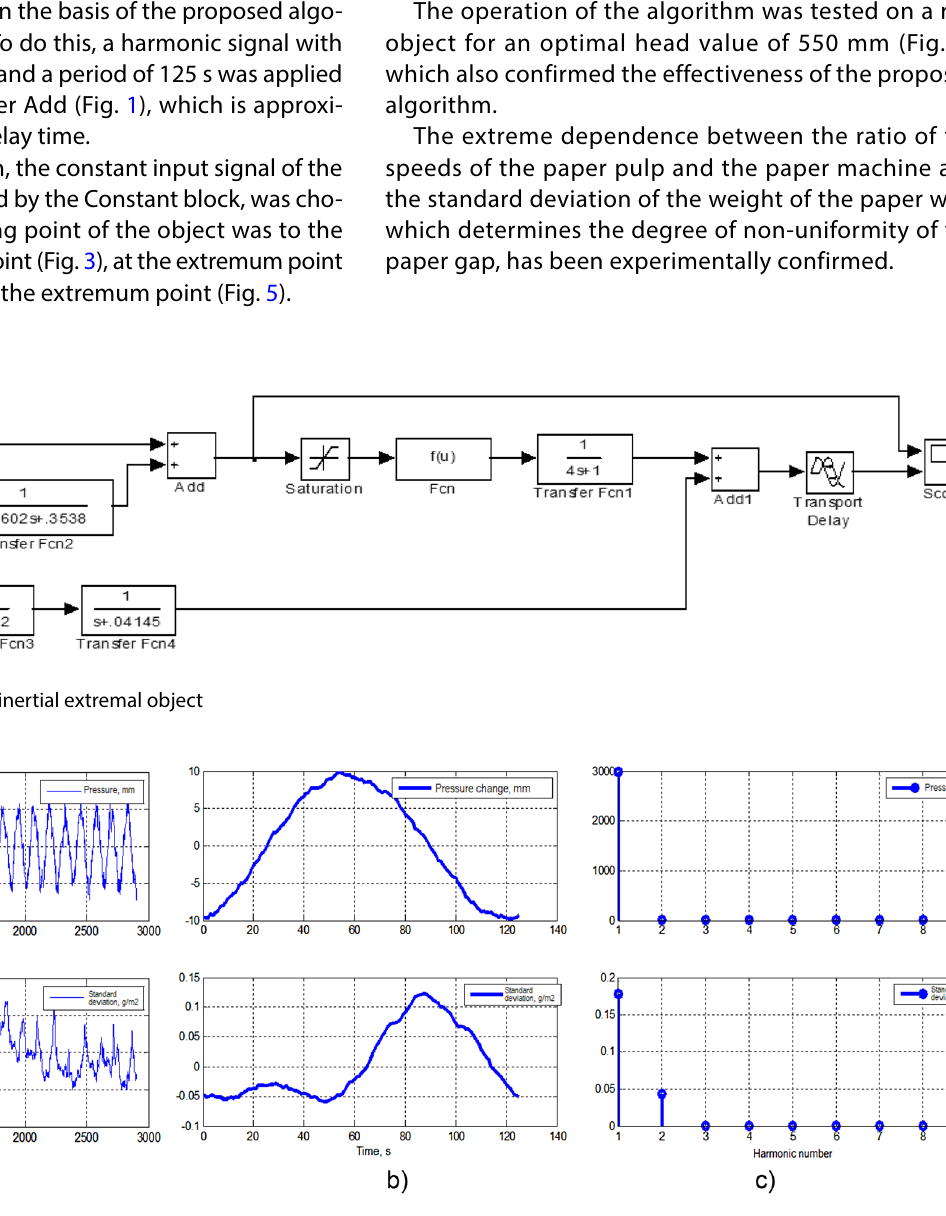
Fig. 3 Simulation results with an average value of the input signal greater than the optimal head (690 mm): a input harmonic and output noisy signals of an inertial extremal object; b results of syn-